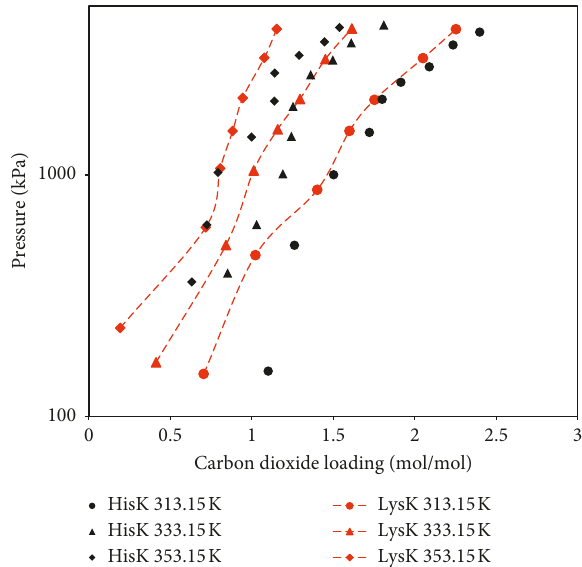
Figure 4: Experimental solubility behaviour of carbon dioxide in 1 M aqueous potassium salt of L -histidine and data of 1M aqueous potassium salt of lysinate [7].